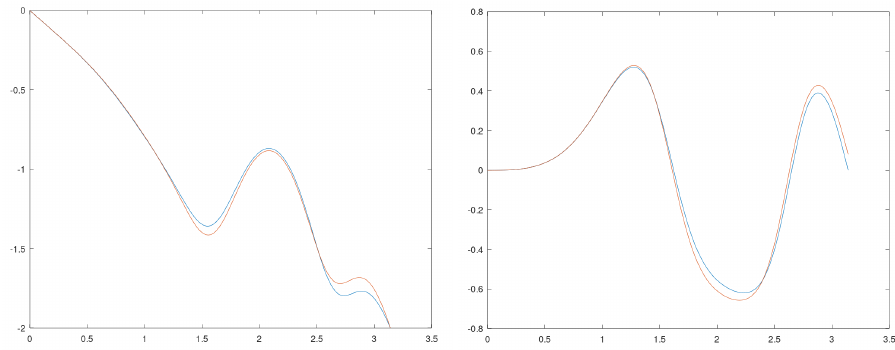
Figure 1. Plots of Re q 1 ( x ) , Re ˜ q 1 ( x ) and Im q 1 ( x ) , Im ˜ q 1 ( x ) for δ = 0.01.